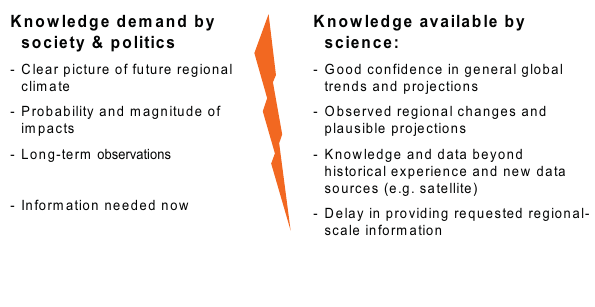
Fig. 5. The discrepancy between knowledge demand and knowl- edge